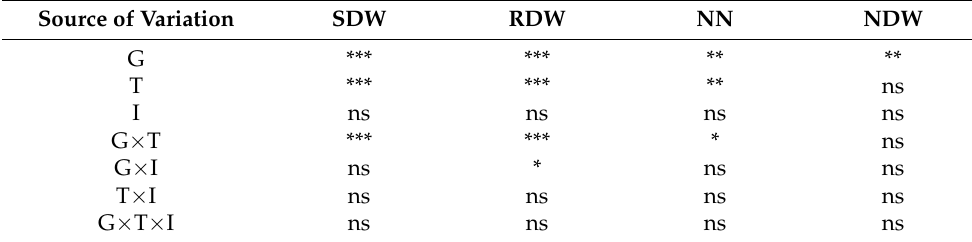
Table 3. Analysis of variance in the greenhouse experiment, displaying genotypes (G), strains (I), treatments (T), genotype strain interaction (G × I), genotype treatment interaction (G × T), treatment strain interaction (T × I) and genotype treatment strain interaction (G × T × I). Source of Variation SDW RDW NN NDW G *** *** ** ** T *** *** ** ns I ns ns ns ns G × T *** *** * ns G × I ns * ns ns T × I ns ns ns ns G × T × I ns ns ns ns *** p < 0.0001, ** p < 0.001, * p < 0.01, ns = not